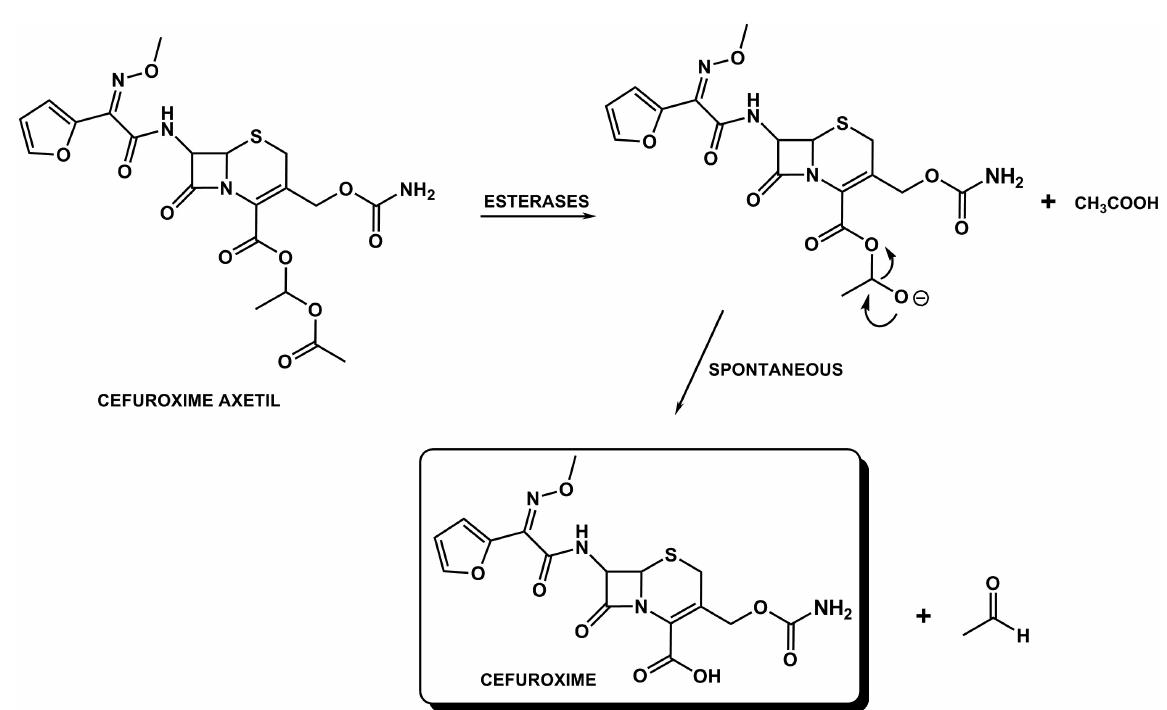
FIGURE 21 - Cefuroxime axetil structure and its conversion into cefuroxime. (Figure 23). Chloramphenicol palmitate is a prodrug